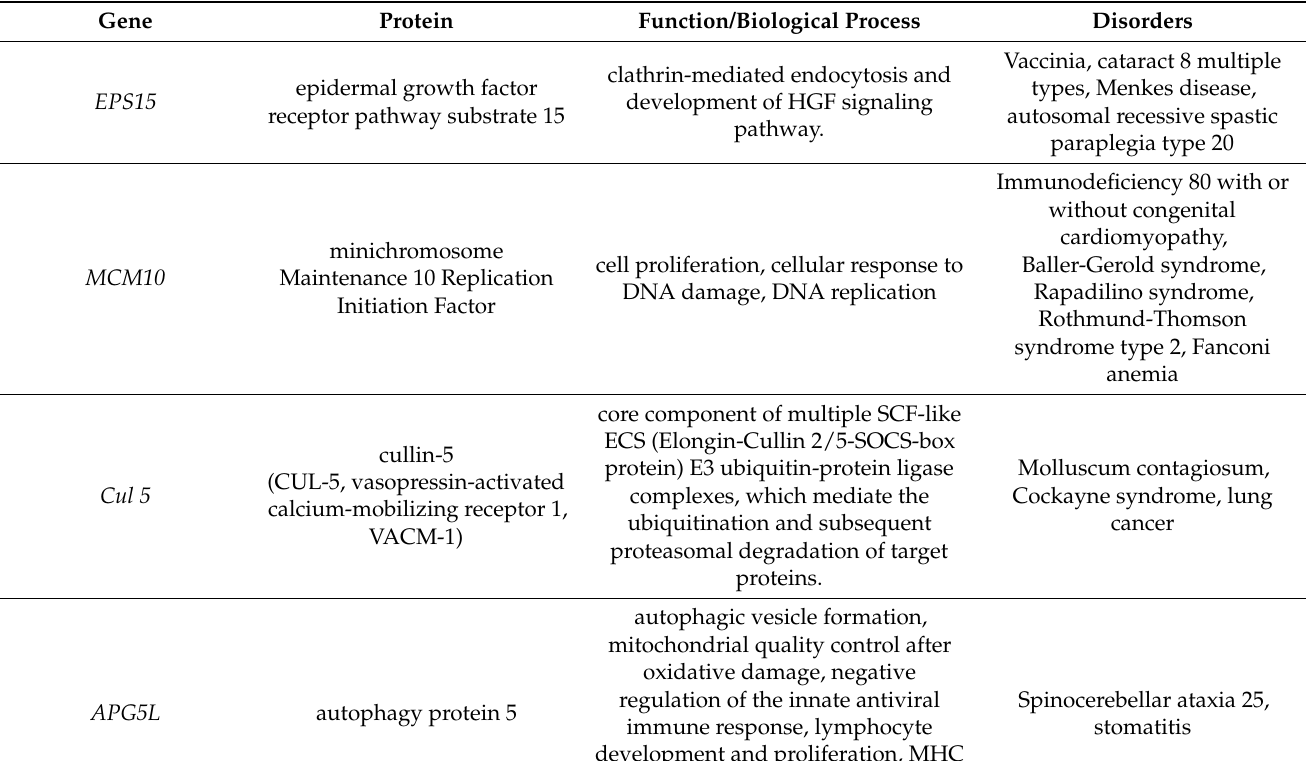
Table 2. Genes and proteins involved in the pathogenesis of various diseases, the expression of which is regulated by the KE